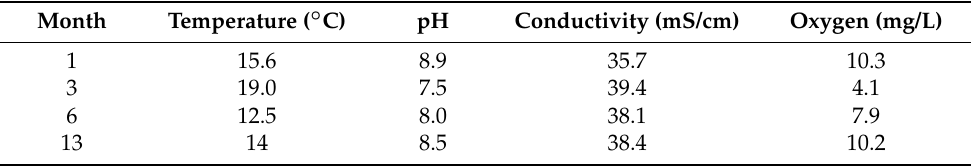
Table 4. Seawater characteristics during immersion of